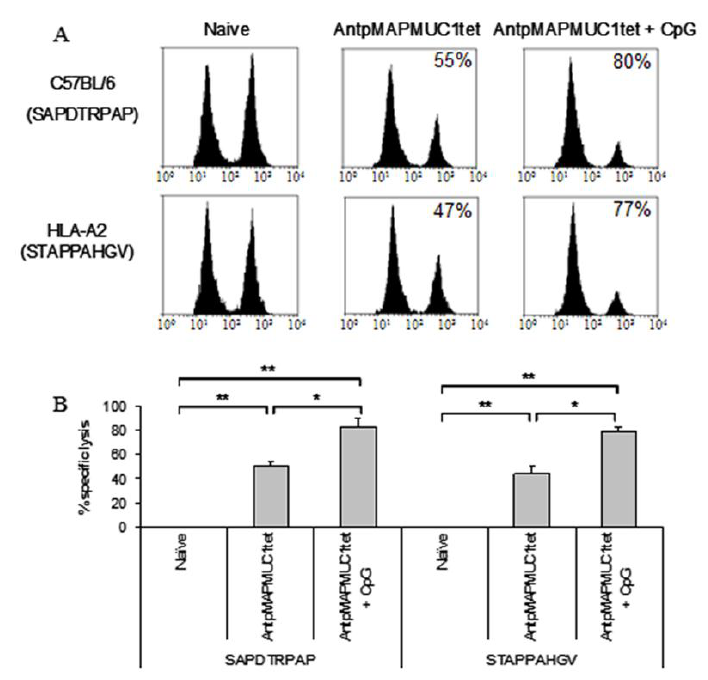
Figure 7. Cellular immune responses in AntpMAPMUC1tet immunised mice measured as in vivo CTL killing assays. ( A ) C57BL/6 or HLA-A2 mice were immunised i.d. with PBS, 100 µ g AntpMAPMUC1tet or 100 µ g AntpMAPMUC1tet + 50 µ g CpG and the percent MUC1K b or MUC1A2-specific